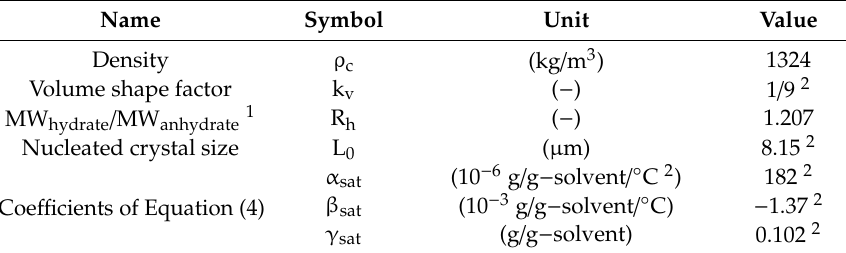
Table 1. Physical properties of L-arginine